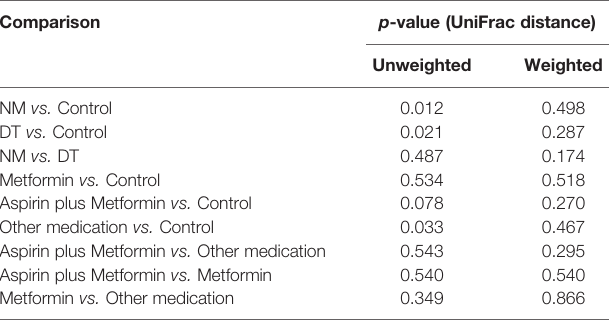
TABLE 2 | Results from nonparametric MANOVA analysis based on UniFrac distance.